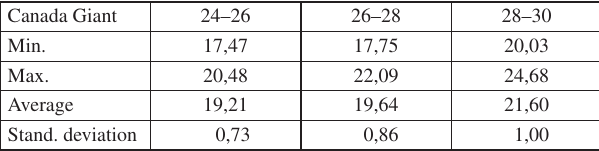
Table 3: The average values for the thickness (mm)